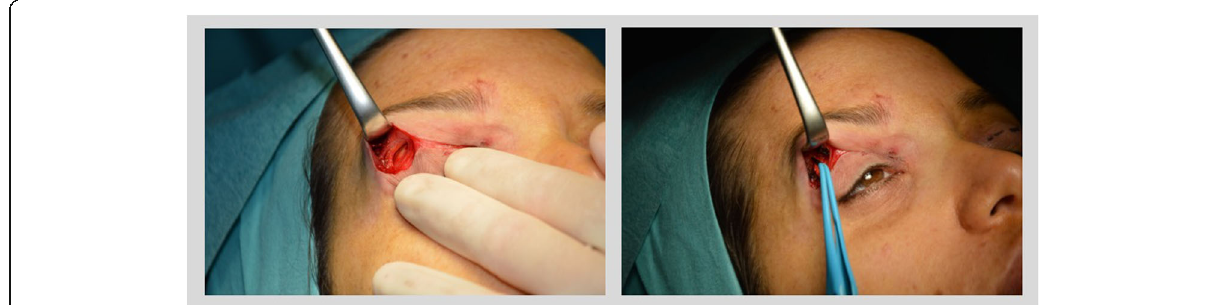
Fig. 3 Lateral CSM motor innervation resection. Lateral to the lateral, subcutaneous insertion of the CSM, a tunnel was dissected in the preseptal space between superficial temporal fascia and the subcutaneous tissue. In this space, motor fibers were cauterized via a bipolar